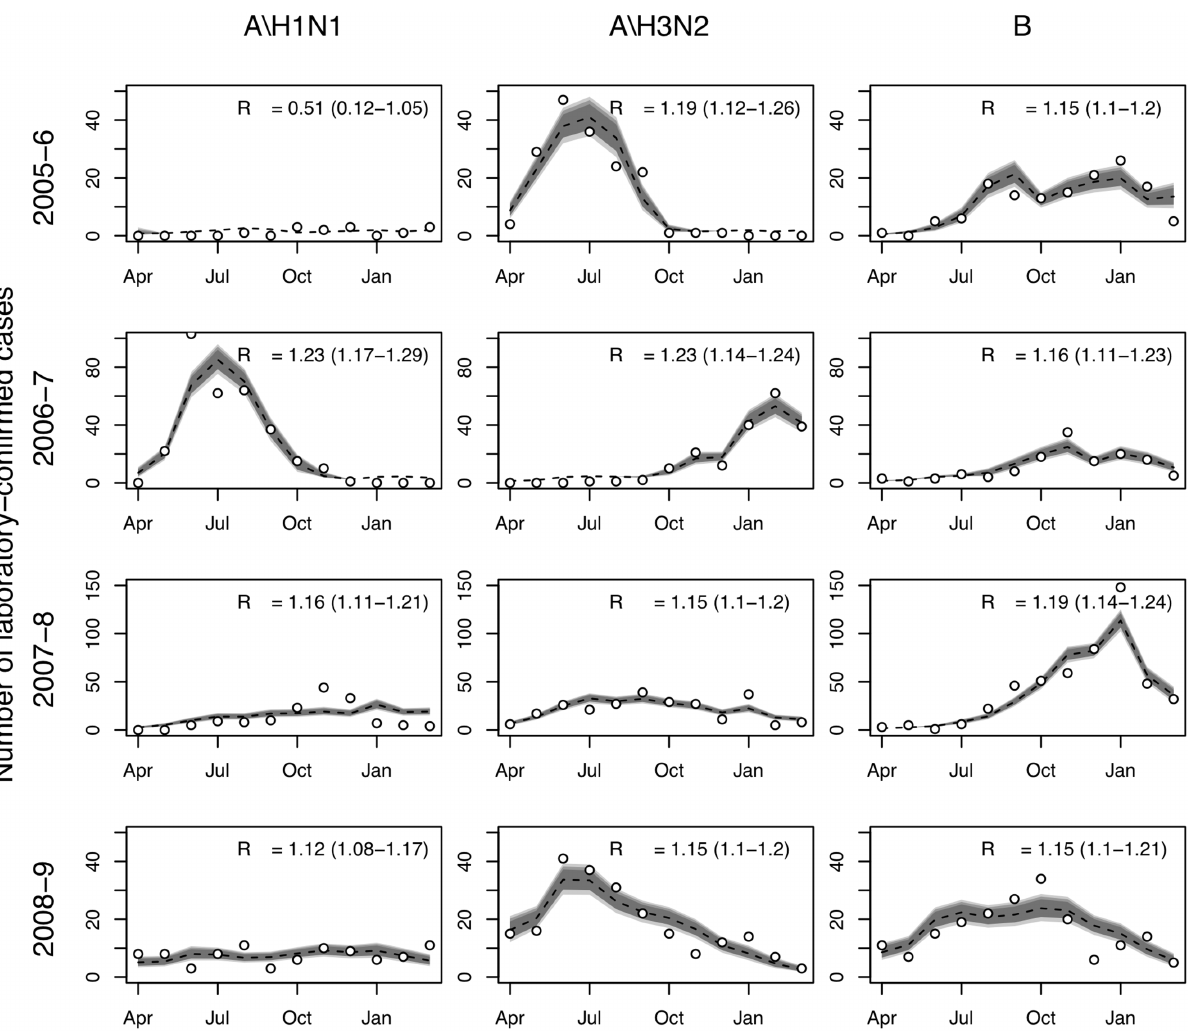
Fig 2. Model fits to laboratory-confirmed influenza surveillance data. Monthly numbers of laboratory-confirmed influenza cases (circles) and model predictions: median (broken line) and 95%, 90%, and 80% (gray shading) prediction intervals for the expected number of cases. Also shown is the estimated value of R 0 and associated 95%